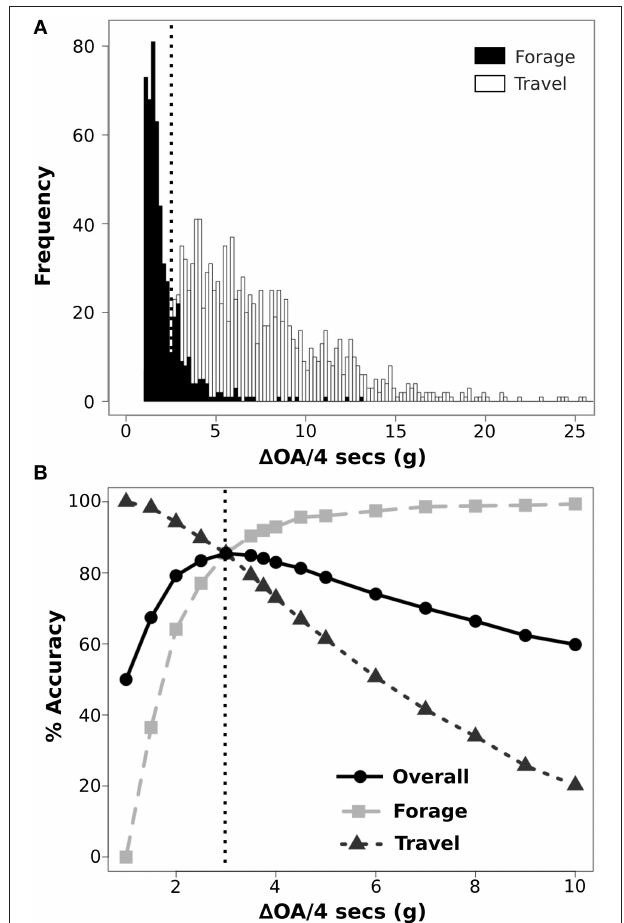
FIGURE 2 | Example illustrating method for determination of threshold values for separation of behavioral states using accelerometer data from collars attached to snowshoe hares. Histograms provide visualization of percent overlap between two behavioral categories using a given summary statistic (A) . Optimization is performed by examining the accuracy of the behavioral classification between two behavioral states across a range of values and selecting the value at which the overall accuracy is the highest and where the individual accuracy of each behavior intersects (B) . Dotted line represents the selected threshold value for classifying accelerometer data into forage and travel using 1